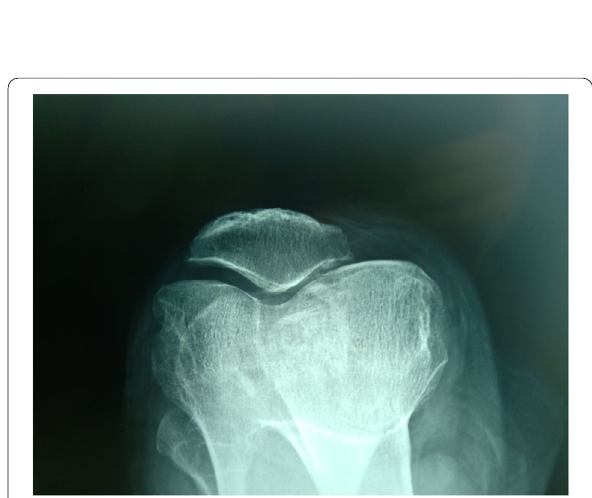
Fig. 3 Patellofemoral joint osteoarthritis in the skyline view. The patellofemoral joints are degenerated, and the space between the patellofemoral joints is